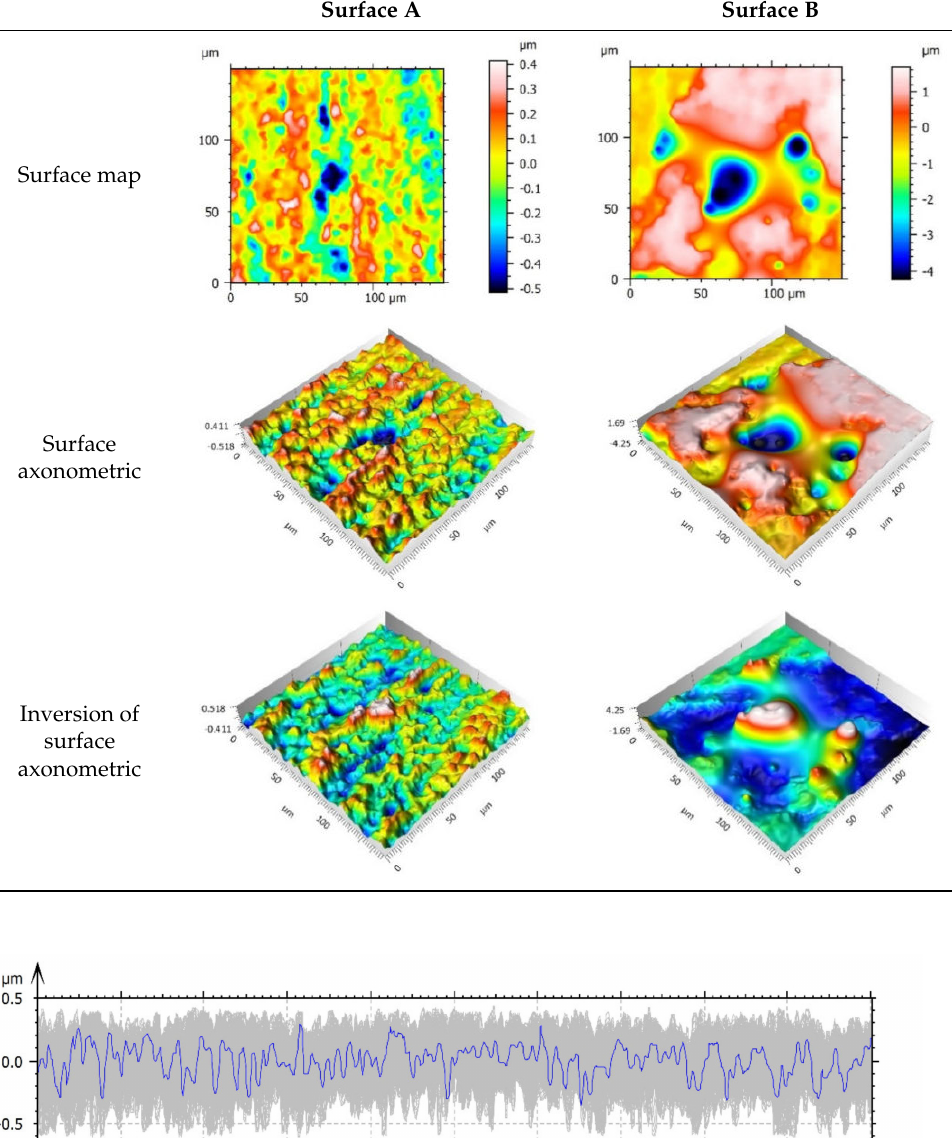
Table 4. Results of manufactured surface topography—characteristic peaks or pits.